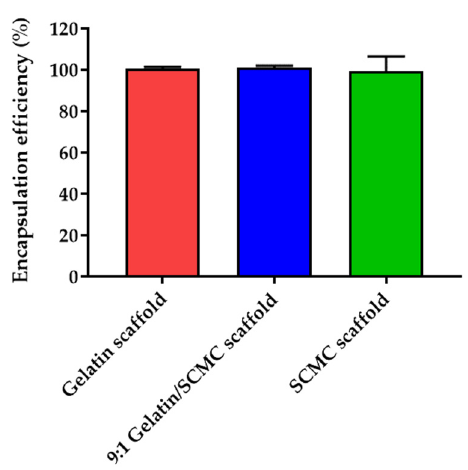
Figure 6. DOX encapsulation efficiency (%) of gelatin, 9:1 gelatin/SCMC, and SCMC scaffolds. Data